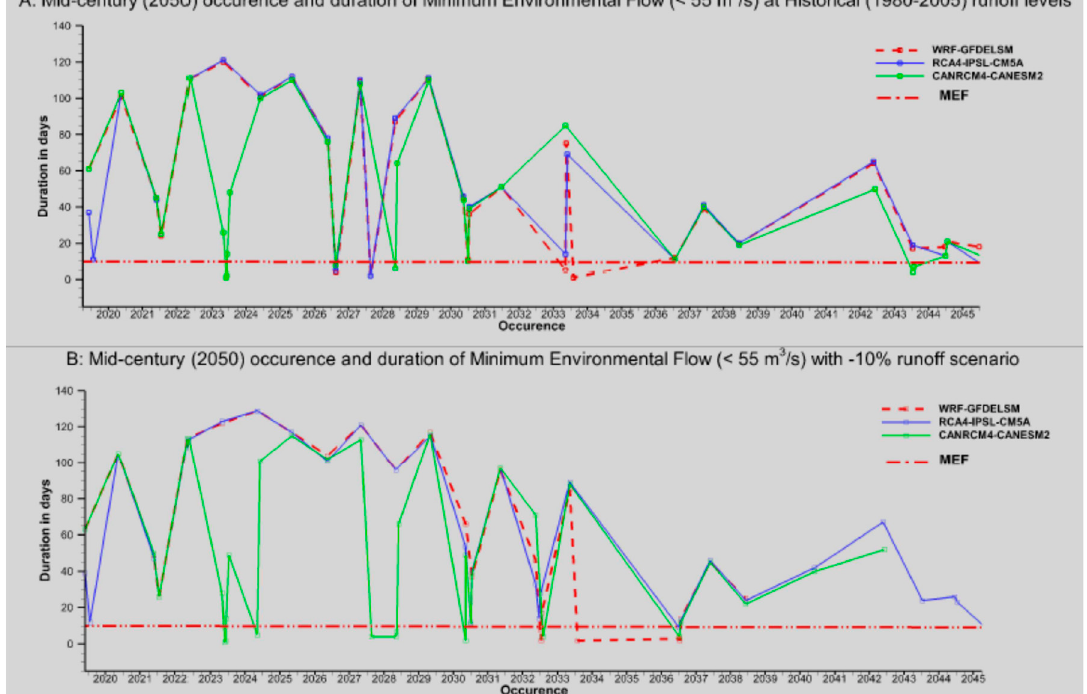
Figure 10. Projected occurrence and duration of minimum environmental flow (MEF) at Niamey gauging station: ( A ) runoff kept at the historical level scenario, and ( B ) scenario of − 10% runoff change compared to the historical level.